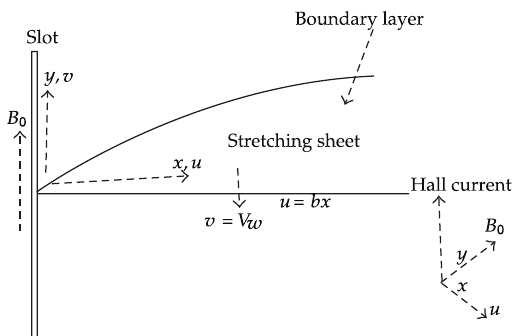
Figure 1: The physical configuration and coordinate system for the boundary layer